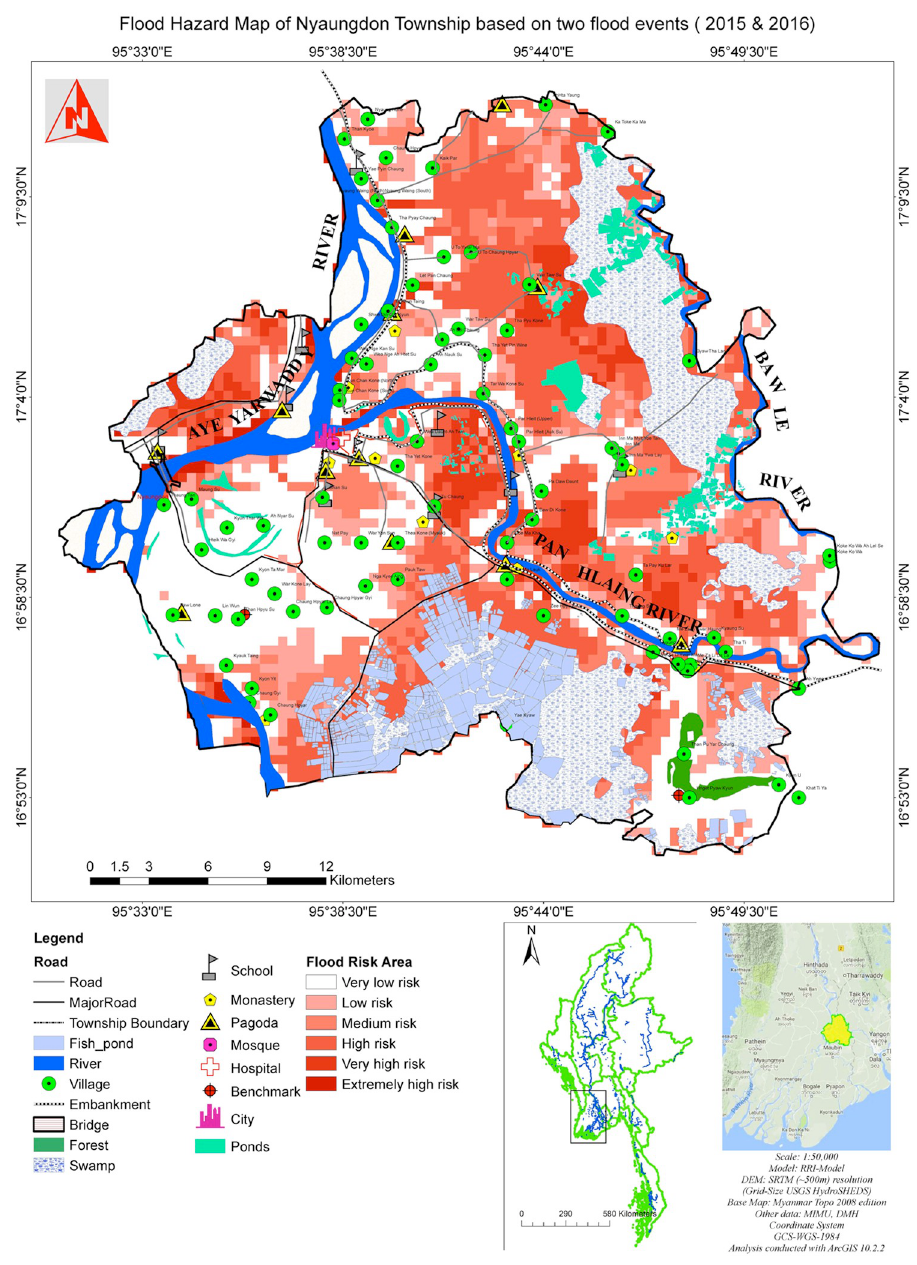
Fig 8. Flood hazard map of Nyaungdon Township based on the composite results of the 2015 and 2016 flood events, which corresponds to a flood event with about 30-year return period.